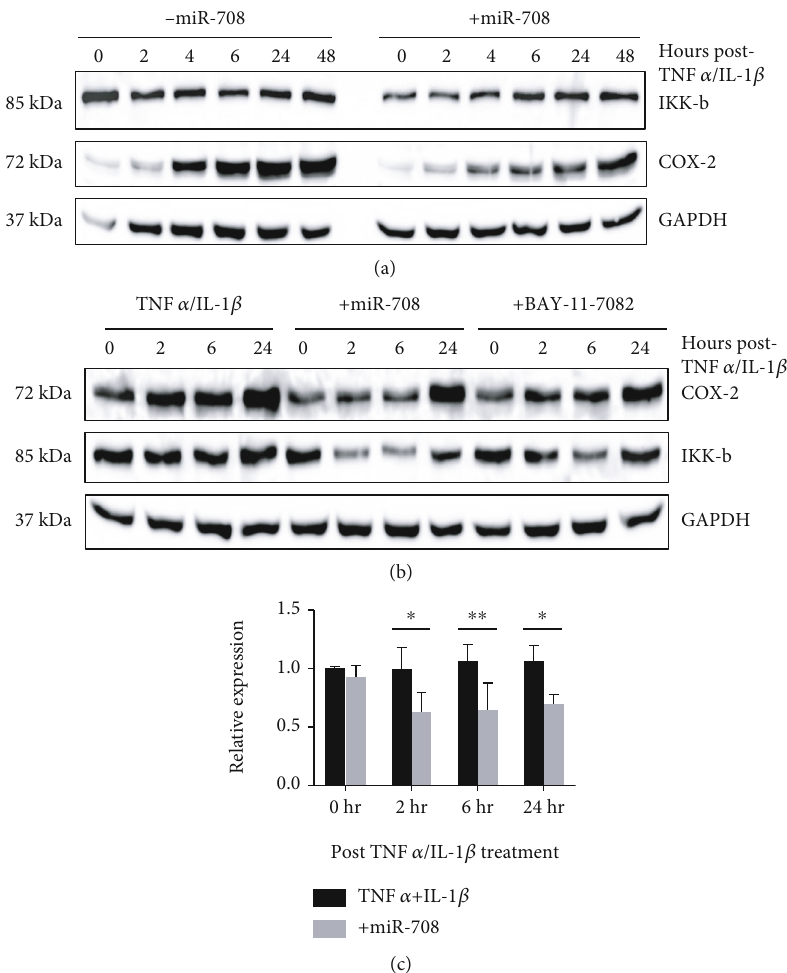
Figure 5: miR-708 and NF- κ B inhibition decreases IKK β and COX-2 protein expression, respectively, in TNF α /IL-1 β -treated diseased lung cells. (a) Representative western blot examining COX-2 and IKK β (IKK-b) protein expression in A549 cells transiently transfected with mock (left) or 25 nM miR-708 (right) in combination with TNF α /IL-1 β for 0 – 48 hours. (b) Representative western blot examining COX-2 and IKK β (IKK-b) protein expression in A549 cells transiently transfected with mock (left), 25 nM miR-708 (middle), or 10 μ M BAY-11-7082 in combination with TNF α /IL-1 β for 0 – 24 hours. (c) Quanti fi cation of IKK β protein expression from representative western blot (b) and others (data not shown). IKK β expression was normalized to GAPDH protein expression and TNF α /IL-1 β 0 h (left black bar). ∗ p < 0 : 05 and ∗∗ p < 0 : 01 , n ≥ 3